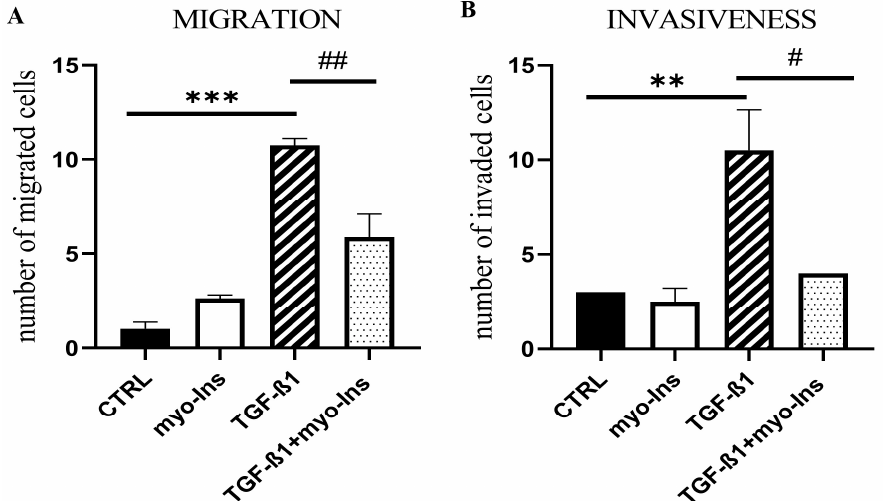
Figure 5. Myo-Ins inhibits motility and invasiveness. Quantification of the total number of migrating and invasive MCF-10A cells upon treatment with TGF- β alone or with myo-Ins following TGF- β stimulation. Transformed cells show an increase in motility ( A ) up to the height-fold compared to the control sample. Similarly, invasiveness is three-times higher in TGF- β 1 treated cells than in the controls ( B ). Addition of myo-Ins significantly inhibits motility (<50% than in TGF- β 1 treated cells) and almost completely nullifies the invasive capacity of transformed cells. Histograms indicate the mean value ± SD. ** p < 0.01; *** p < 0.001 (one-way ANOVA). # p < 0.05; ## p < 0.01. Legend: *: TGF- β 1 vs. CTRL; # TGF- β 1+myo-Ins vs. TGF- β 1.